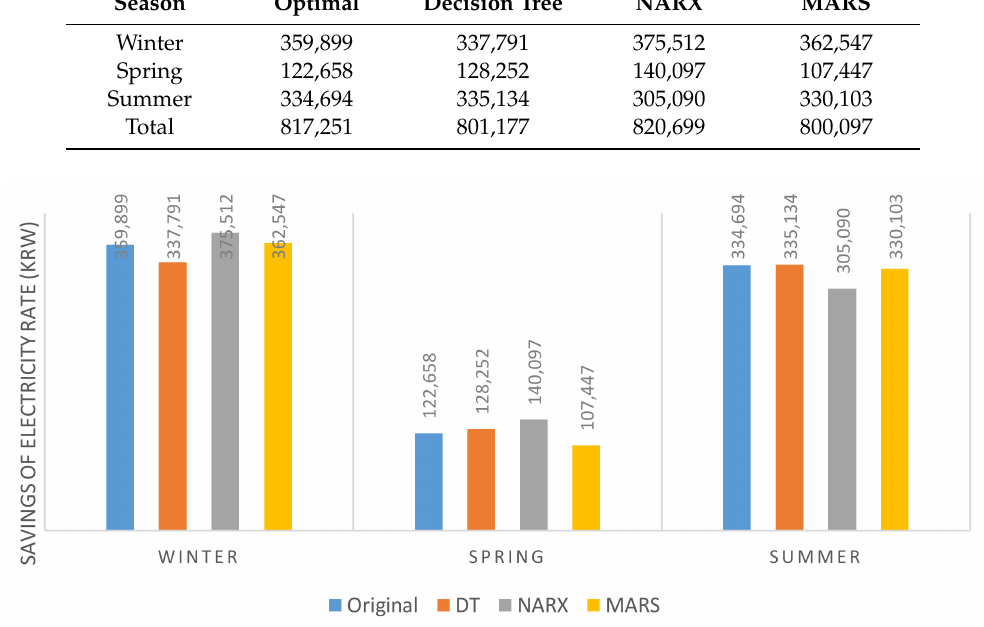
Figure 8. Chart of seasonal savings of electricity rate with Machine learning algorithms.